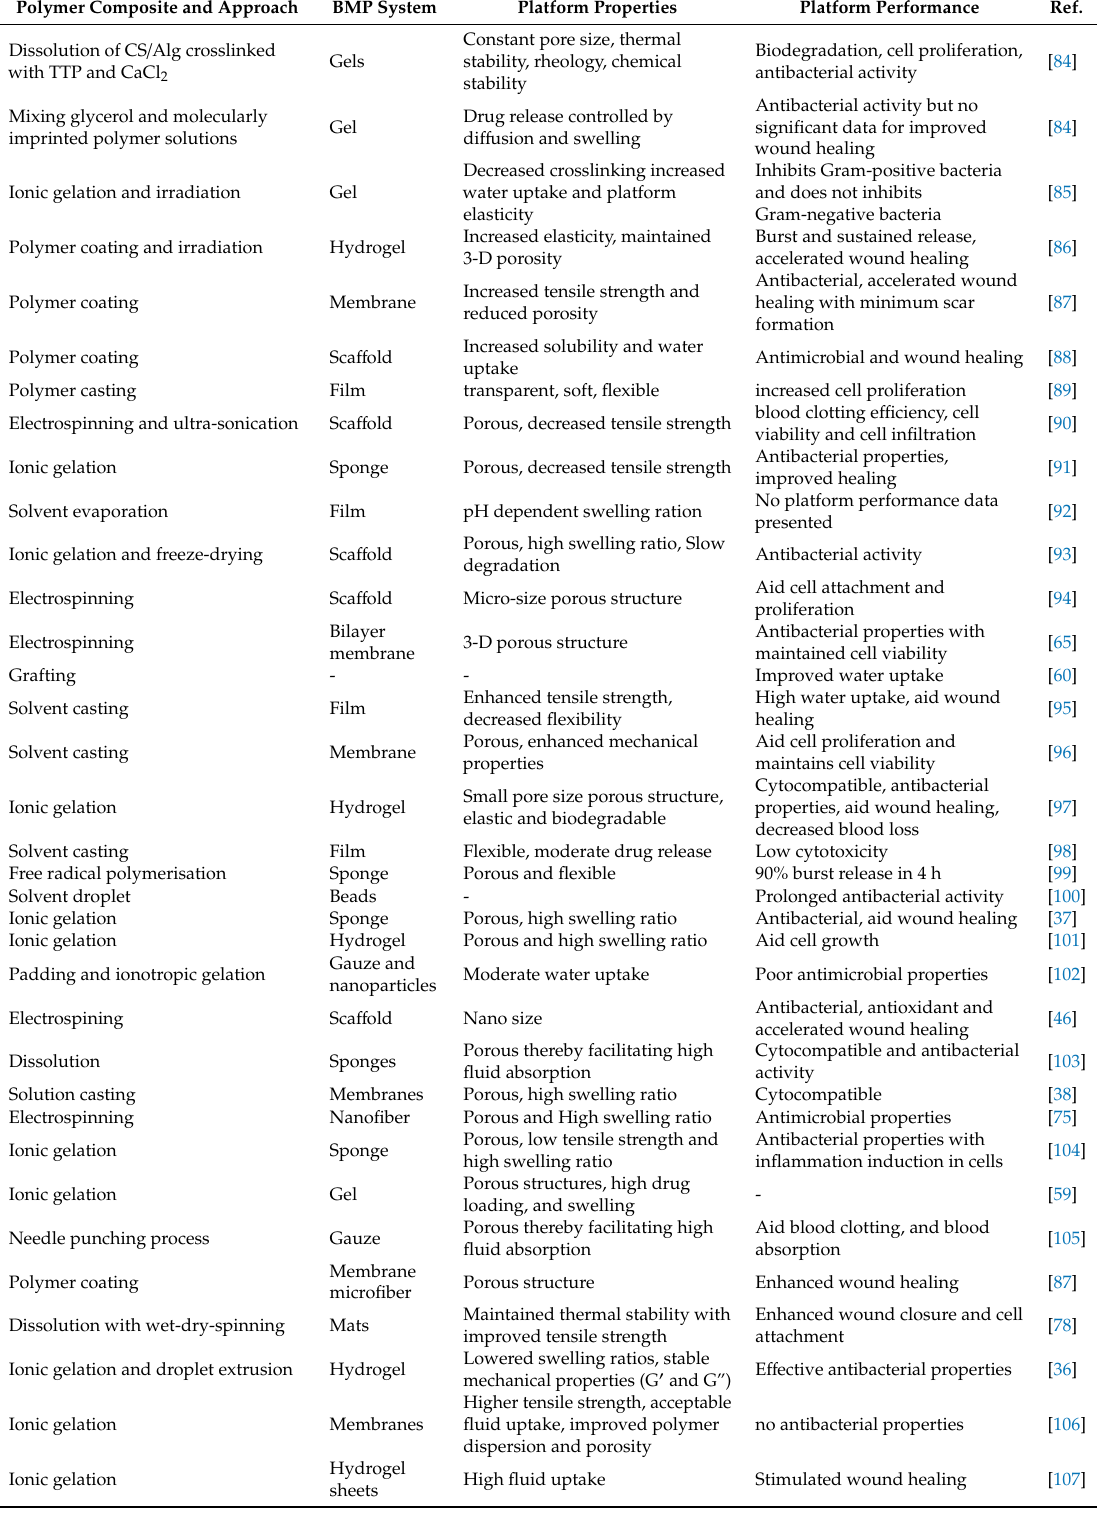
Table 1. BMP fabrication approach and properties a ff ecting translational performance in wound dressing